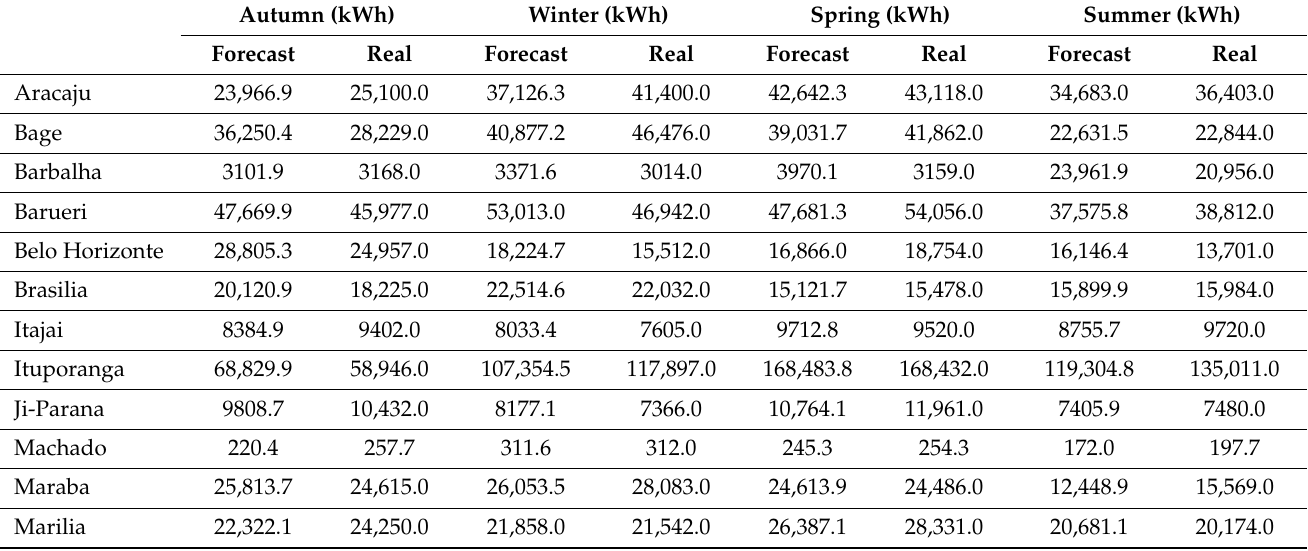
Table 9. Predicted values and actual generation values for each generation plant, grouped by